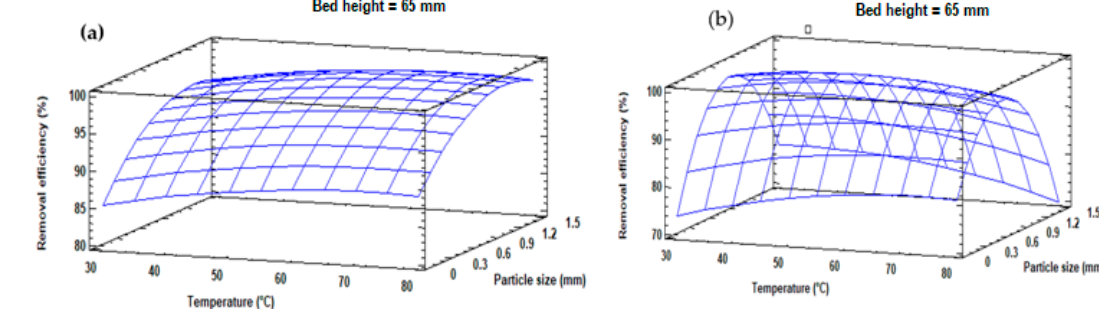
Figure 6. Estimated response area for the removal efficiency of ( a ) CrVI) and ( b ) Ni(II) on YP.